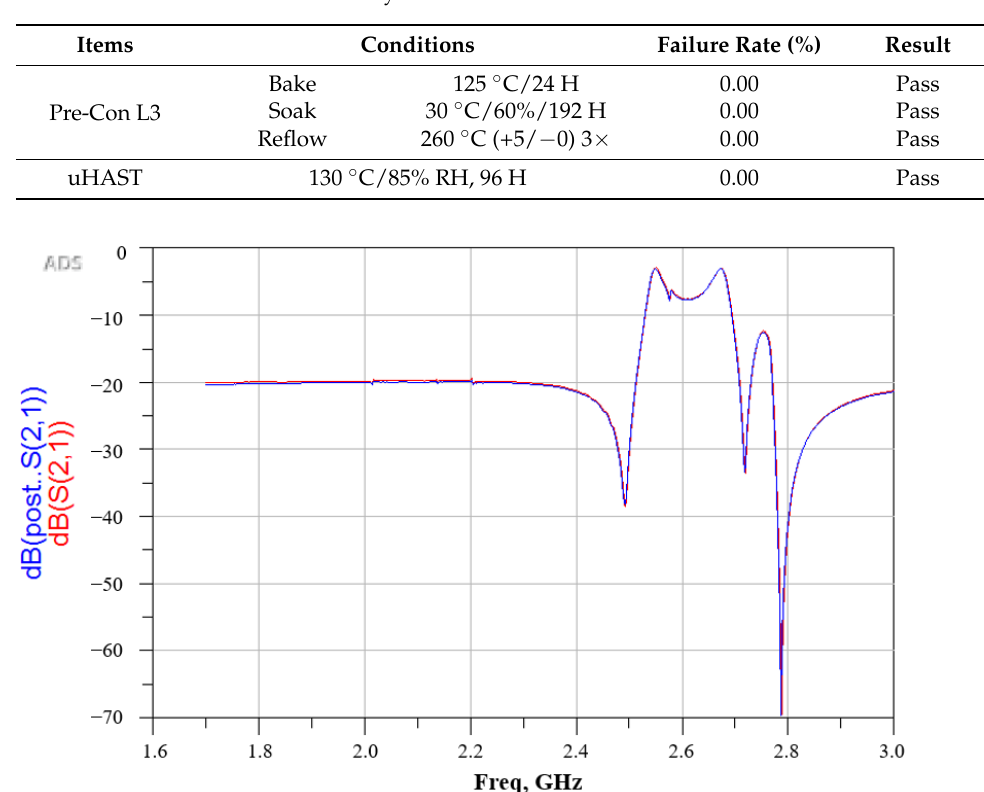
Figure 14. Measurement results of frequency response before and after reliability test.